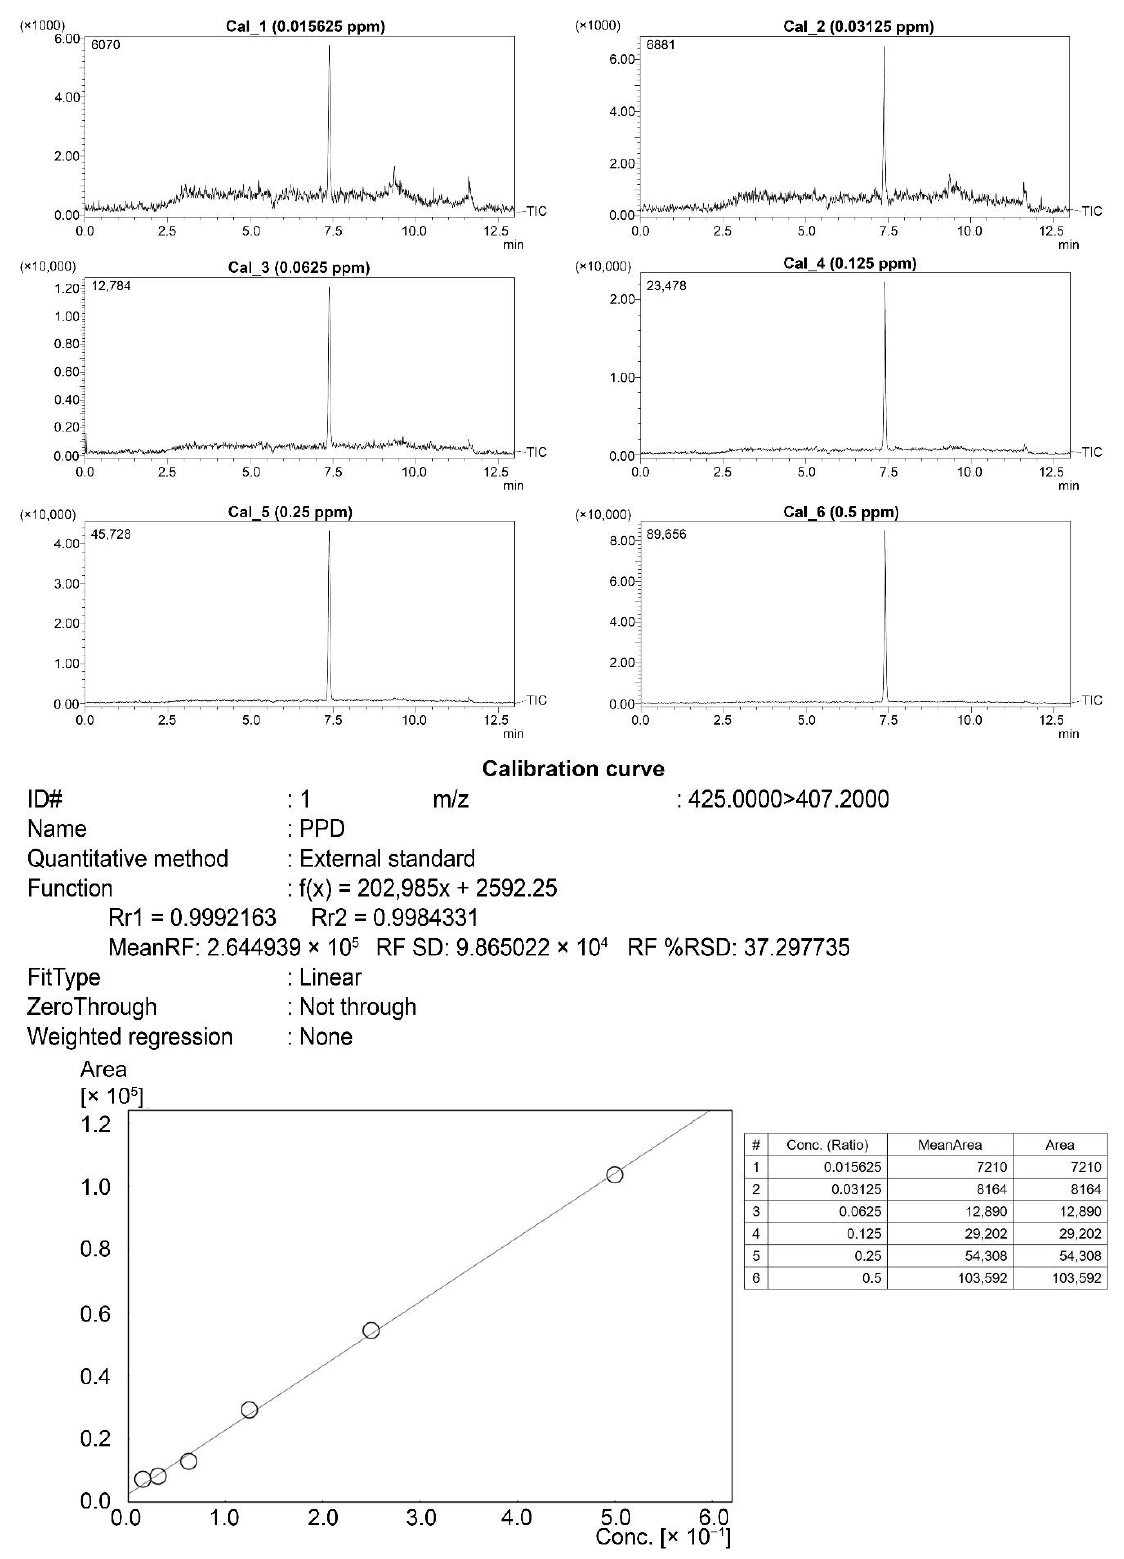
Figure 1. The calibration curve of PPD over the concentration range of 0.0156 – 0.50000 ppm.